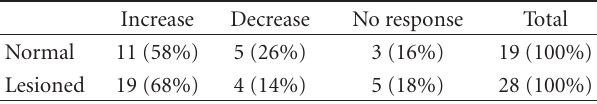
Table 2: Response of GP neurons to 1nmol bethanechol in normal and ipsilateral striatum-lesioned rats.